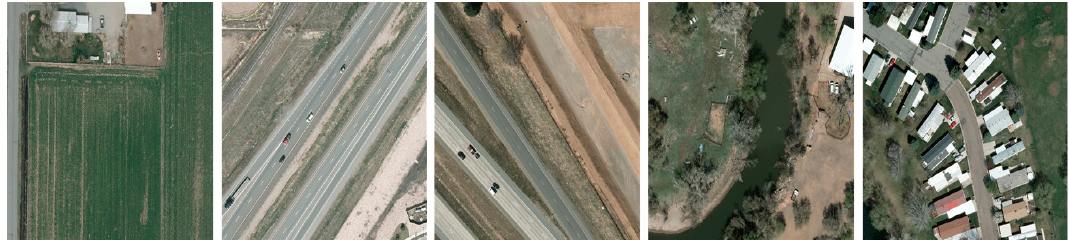
Figure 6. Examples from the VEDAI dataset. Table 1. The statistical data of VEDAI.